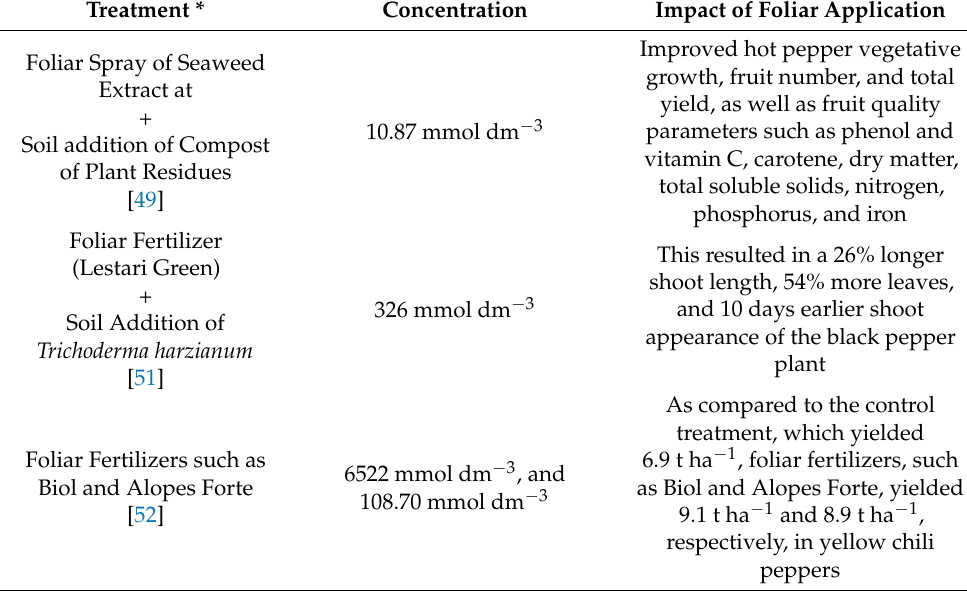
Table 7. Cont. Treatment * Concentration Impact of Foliar